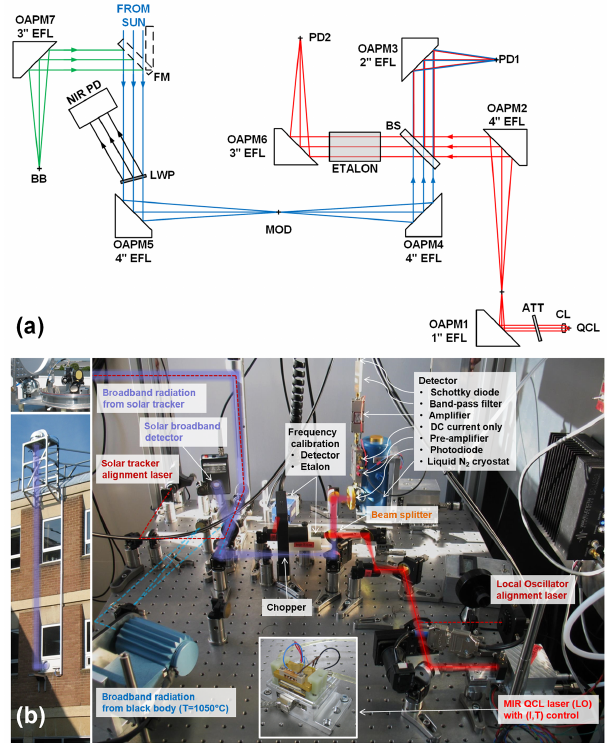
Figure 3. (a) Schematic of the LHR optical layout with the optical path of the LO in red and Sun broadband radiation in blue; (b) anno- tated picture of the breadboard prototype, next to the outdoor wall- mounted structure with optical path used for solar